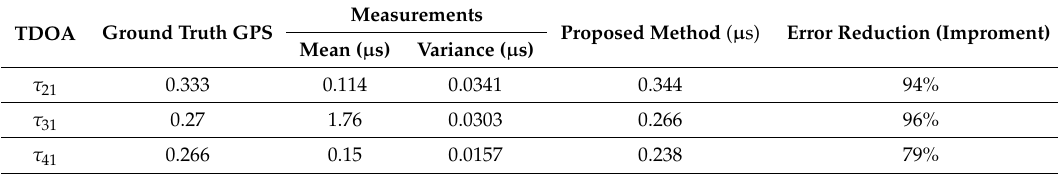
Table 2. Improvement in TDOA position